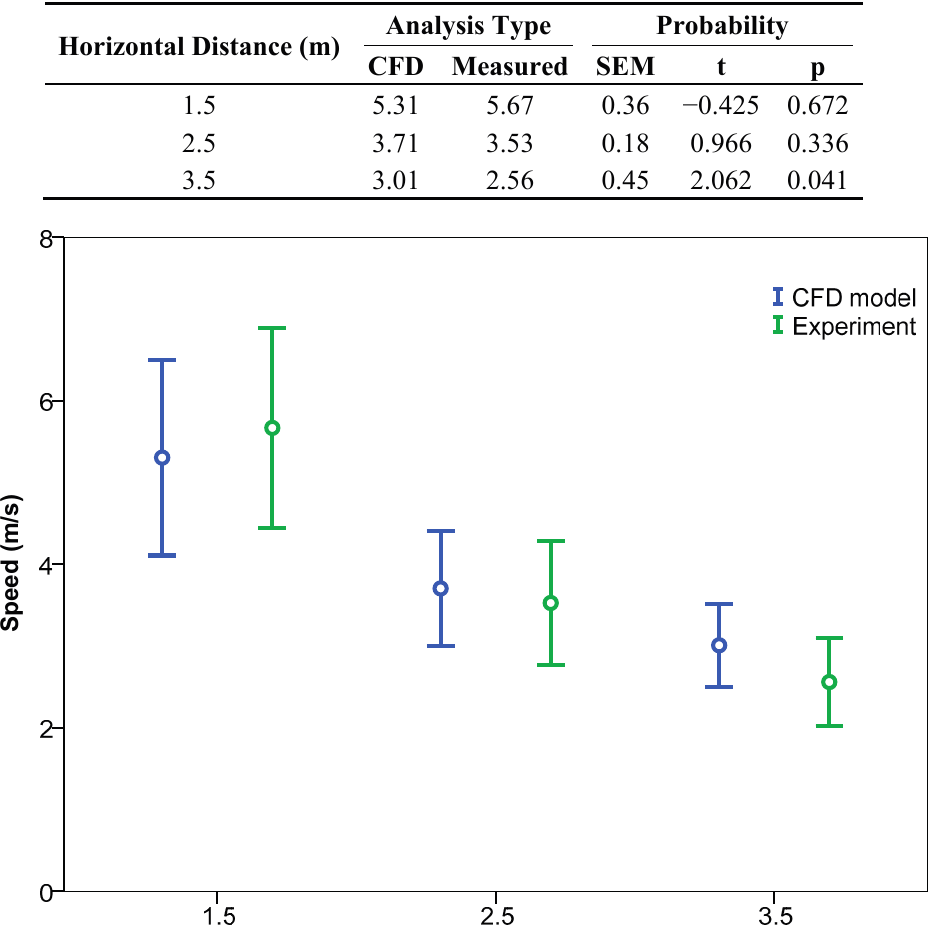
Table 7. Air velocity values according to analysis type and horizontal distance. The Student t test was used to compare the means.